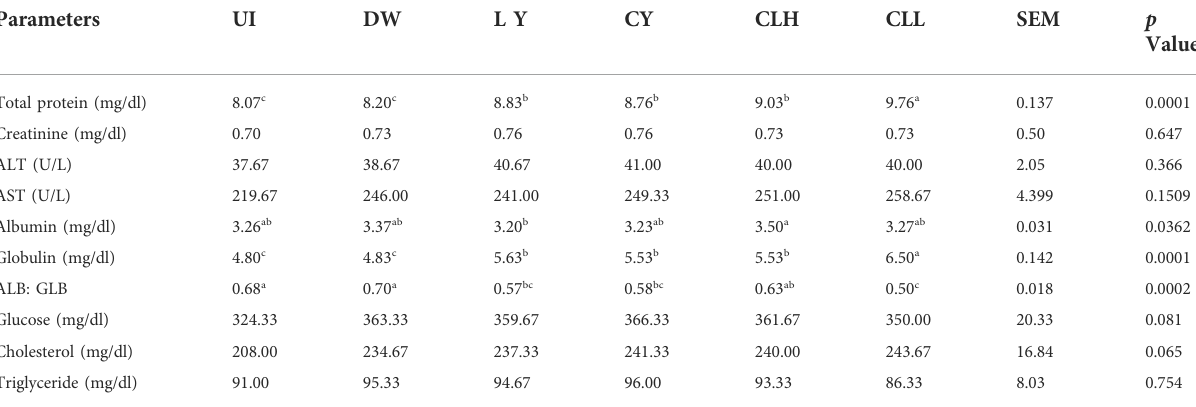
TABLE 4 Effect of in ovo cysteine and lysine on serum biochemical indices of day-old chicks. Parameters